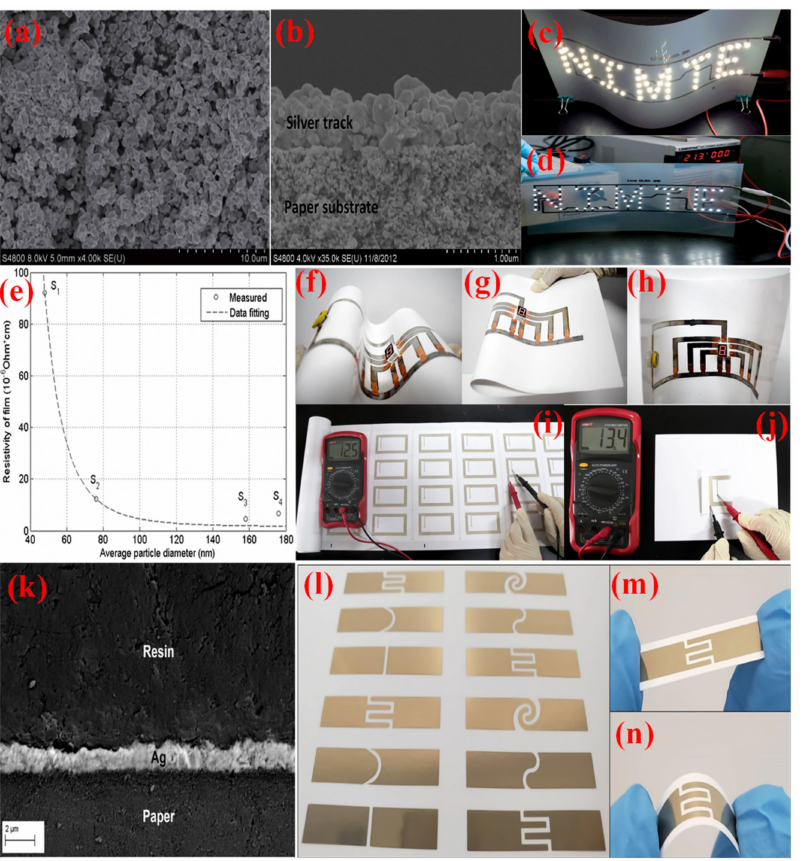
Figure 10. SEM images of Ag NPs powder ( a ), a cross-section of the printed silver track after heating at 50 ◦ C ( b ), and LED device assembled by inkjet printing silver conductive circuits on photo paper ( c ) and PET ( d ) substrate, copied with permission from Ref. [118], Royal Society of Chemistry, 2014. The relationship between the resistivities of Ag NPs-based films and the average diameter of Ag NPs at 140 ◦ C ( e ), hand-drawn 7 segment digital LED display circuit-bent in various shapes ( f – h ), and screen printed high-frequency RFID antenna before ( i ) and after folding ( j ), copied with permission from Ref. [117], Springer-Nature, 2019. SEM cross-section of ink Ag NPs on a photo paper and embedded in an epoxy resin ( k ), designs of the printed electrodes ( l ), with a closer view of design D-6 ( m ), and mechanical bending outwards ( n ) using the ink formulation, copied with permission from Ref. [142], Nature,